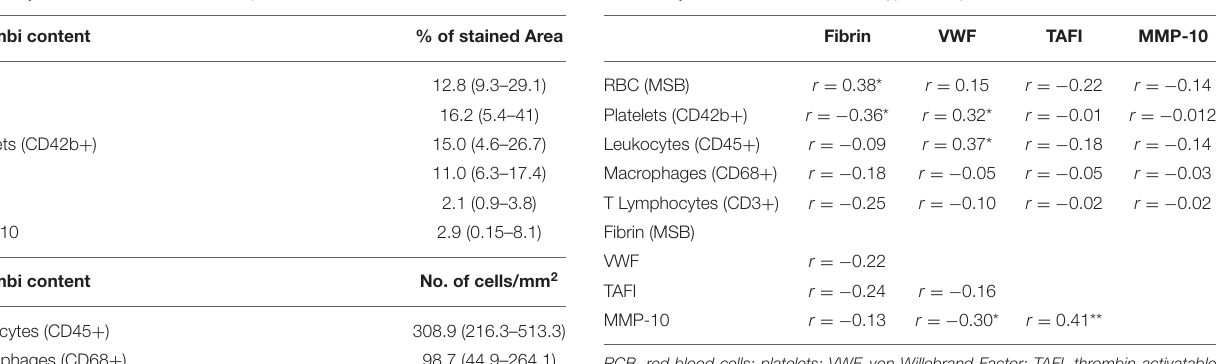
TABLE 2 | Quantification of hemostatic parameters in retrieved stroke thrombi. TABLE 3 | Correlations between cell types and proteins content in stroke